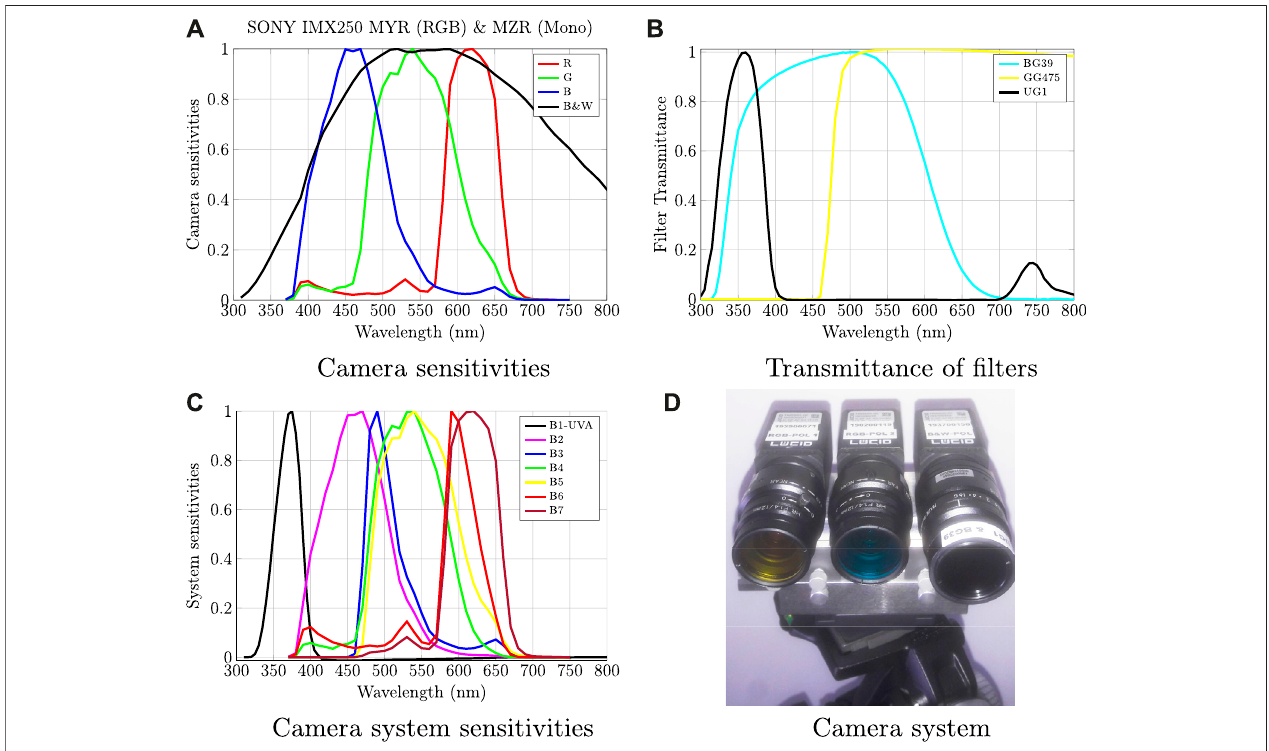
FIGURE 2 | (A) Normalized spectral sensitivities of the two cameras used. (B) Transmittance of the bandpass fi lters. (C) Total system sensitivity, which is a combination of the camera sensitivities with the bandpass fi lters. We show only spectral sensitivities for the 0 ° polarization channels as spectral sensitivities of all polarization channels are very